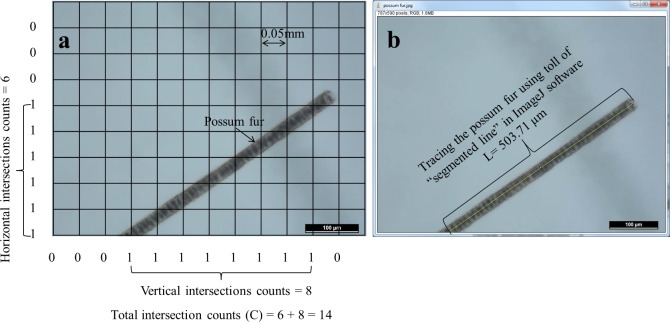
The measurement of possum fur on an image taken under a microscopy at ×200 magnification by using (a) the DGI method–a grid layer (12 × 9, grid size 0.05 × 0.05 mm) was placed on the top of the image and the horizontal and vertical intersections of possum fur that crossed the edges of each square were counted and recorded (e.g., C = 14, the possum fur length calculated using the Tenant equation was 0.550 mm), and (b) the PIP method–the possum fur in the same image was traced (yellow line) manually and measured by the ImageJ software (e.g., L = 0.503 mm).